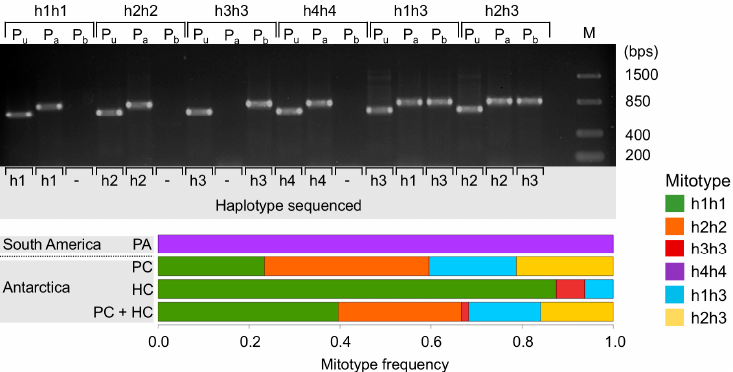
Figure 2. Above: Gel electrophoresis (2% agarose) of PCR-ampli fi ed products from individual samples of the six mitotypes (h1h1, h2h2, h3h3, h4h4, h1h3, and h2h3) using Folmer primers for COI (Pu), and the two haplotype-specific primer combinations designed in this study (Pa: h1-, h2-, and h4-specific; Pb: h3-specific). Sanger sequencing results (haplotypes) of each PCR product are shown in the bo tt om of the gel. Below: mitotype frequencies of bivalves from Punta Arenas (PA, n = 16), Po tt er Cove (PC, n = 47), Hangar Cove (HC, n = 16), and both Antarctic locations together (PC + HC, n = 63).